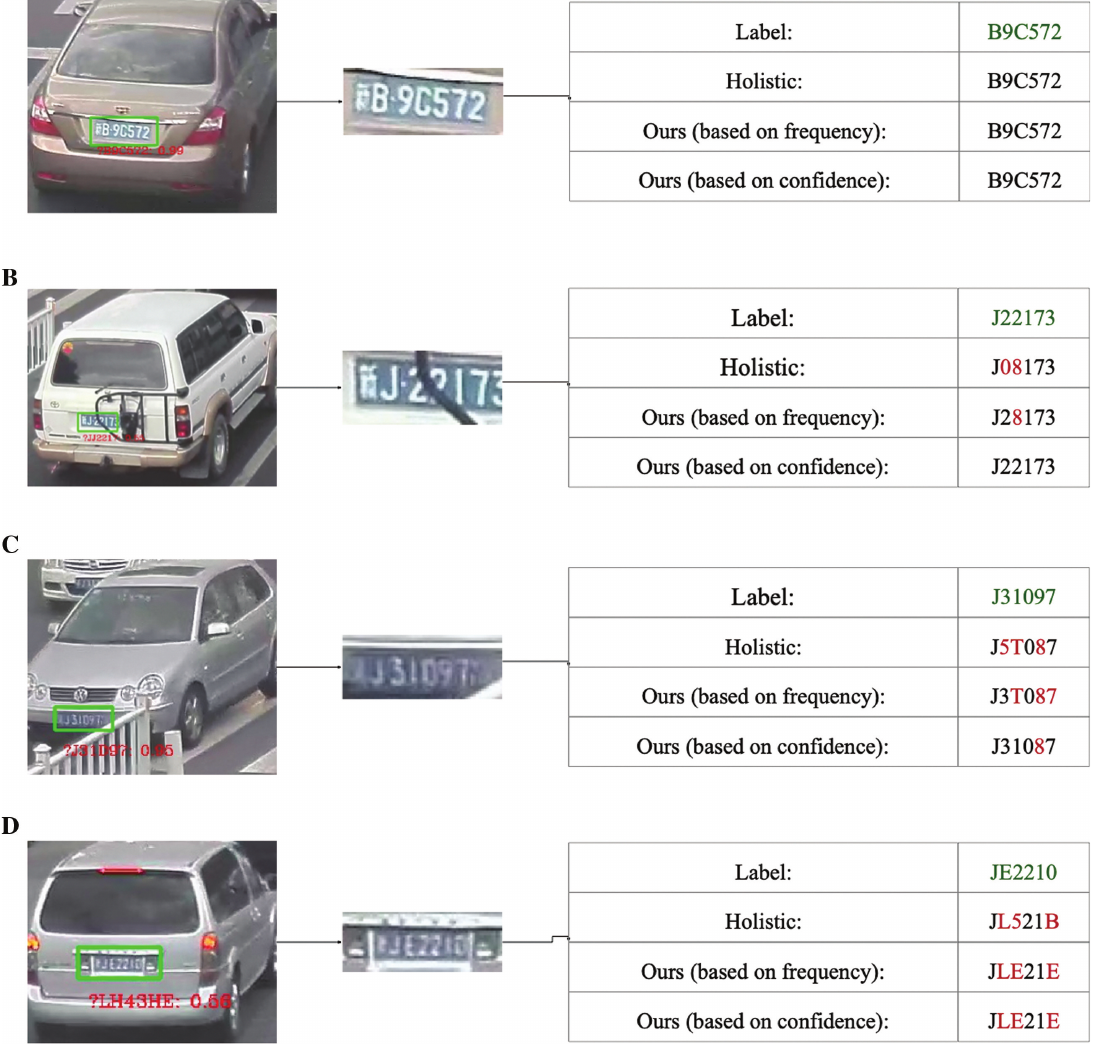
Figure 7: Comparison between Holistic and our methods on some possible situations in the real scene. (A) The license plate is clear, (B and C) the license plate is slightly obscured or has low ambiguity, (D) the license plate has high